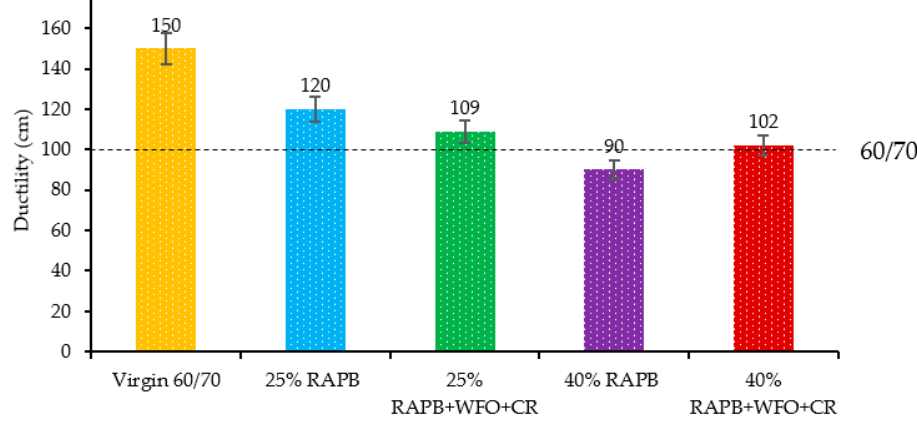
Figure 8. Ductility result for all binders.